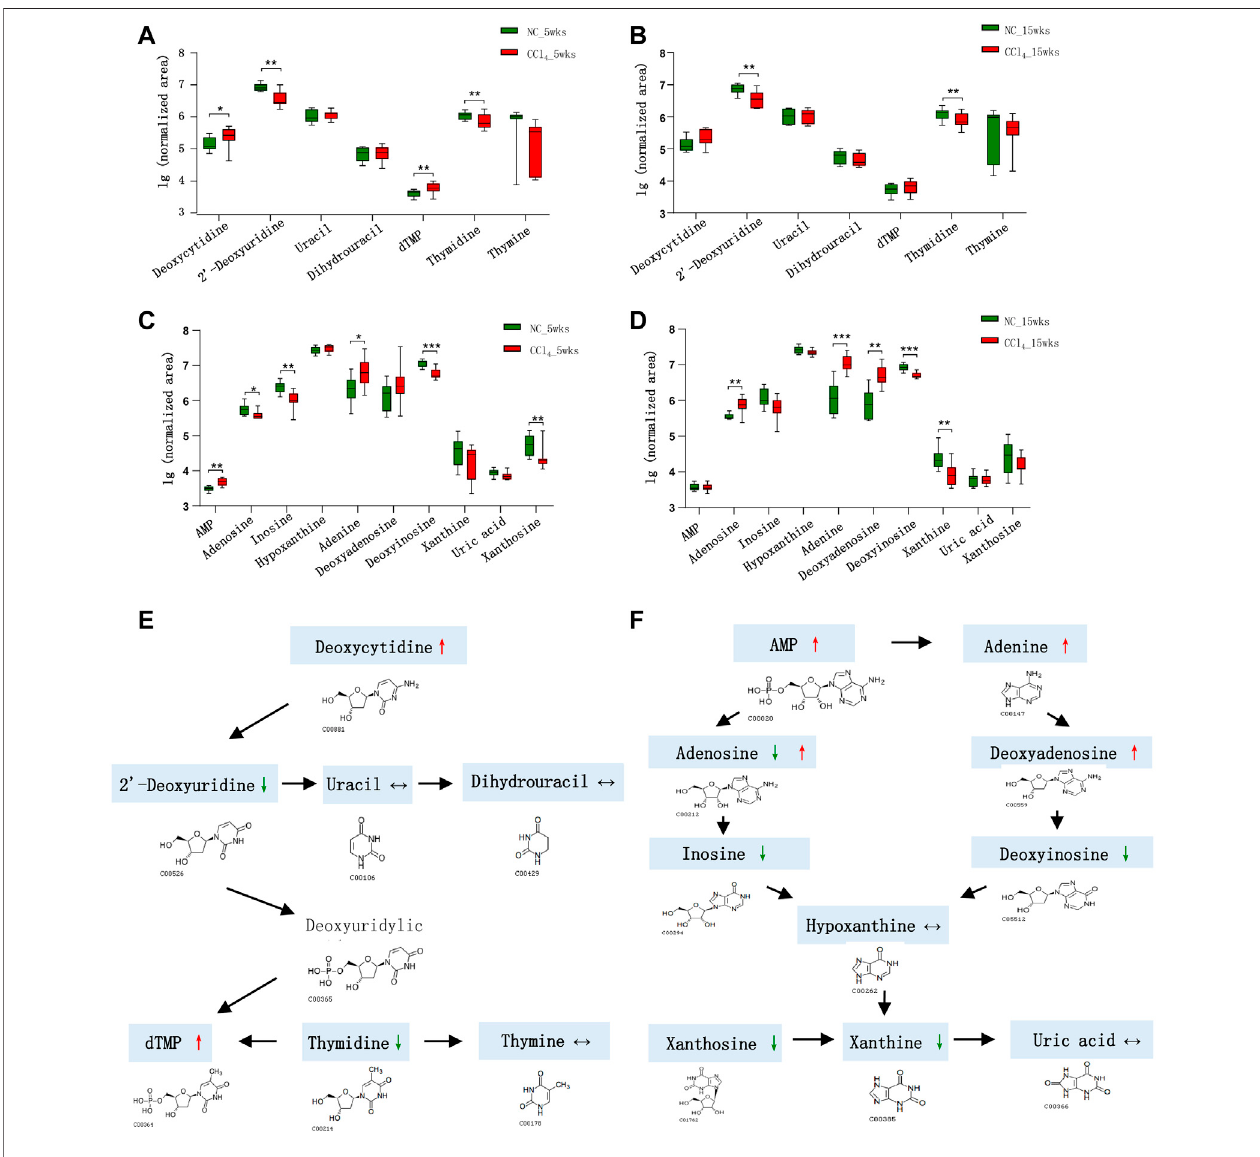
FIGURE 4 | Dysregulation of fecal pyrimidine and purine metabolic pathways in mice during the development of CCl 4 -induced liver cirrhosis. (A, B) Comparison of the detected pyrimidinemetabolites inthefeces ofmice withor withoutCCl 4 intervention for5or 15 weeks. (C,D) Comparison ofthedetected purinemetabolites inthe feces of mice with or without CCl 4 intervention for 5 or 15 weeks. (E, F) Schematic diagram of the disturbed pyrimidine and purine metabolic pathways in CCl 4 -treated mice. Note: Data were given as median with range. * p < 0.05; ** p < 0.01; *** p < 0.001. Abbreviations: NC, normal control; CCl 4 , carbon